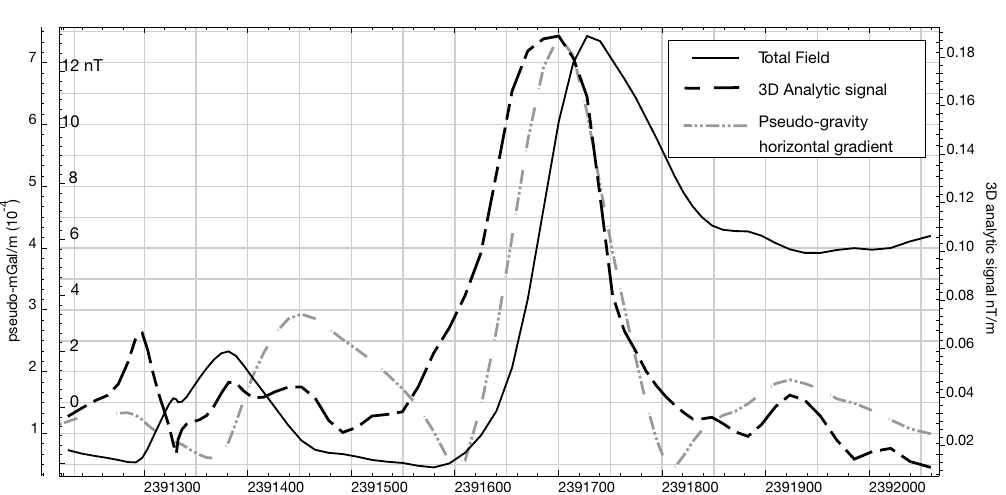
Fig. 3. Profile view comparing HRAM total field data with calculated 3D analytic signal and pseudo gravity signatures. Note the main peaks over the pipeline and over the electric line to the west.